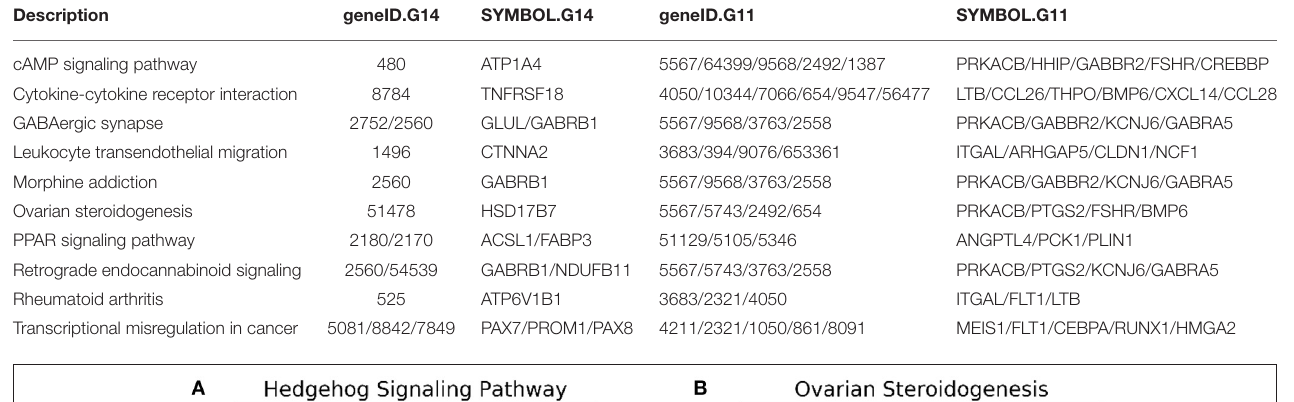
TABLE 3 | Overlapping KEGG pathways and pathway-associated genes derived from the GSE113239 (geneID.G11 and SYMBOL.G11) and GSE144664 datasets (geneID.G14 and SYMBOL.G14).